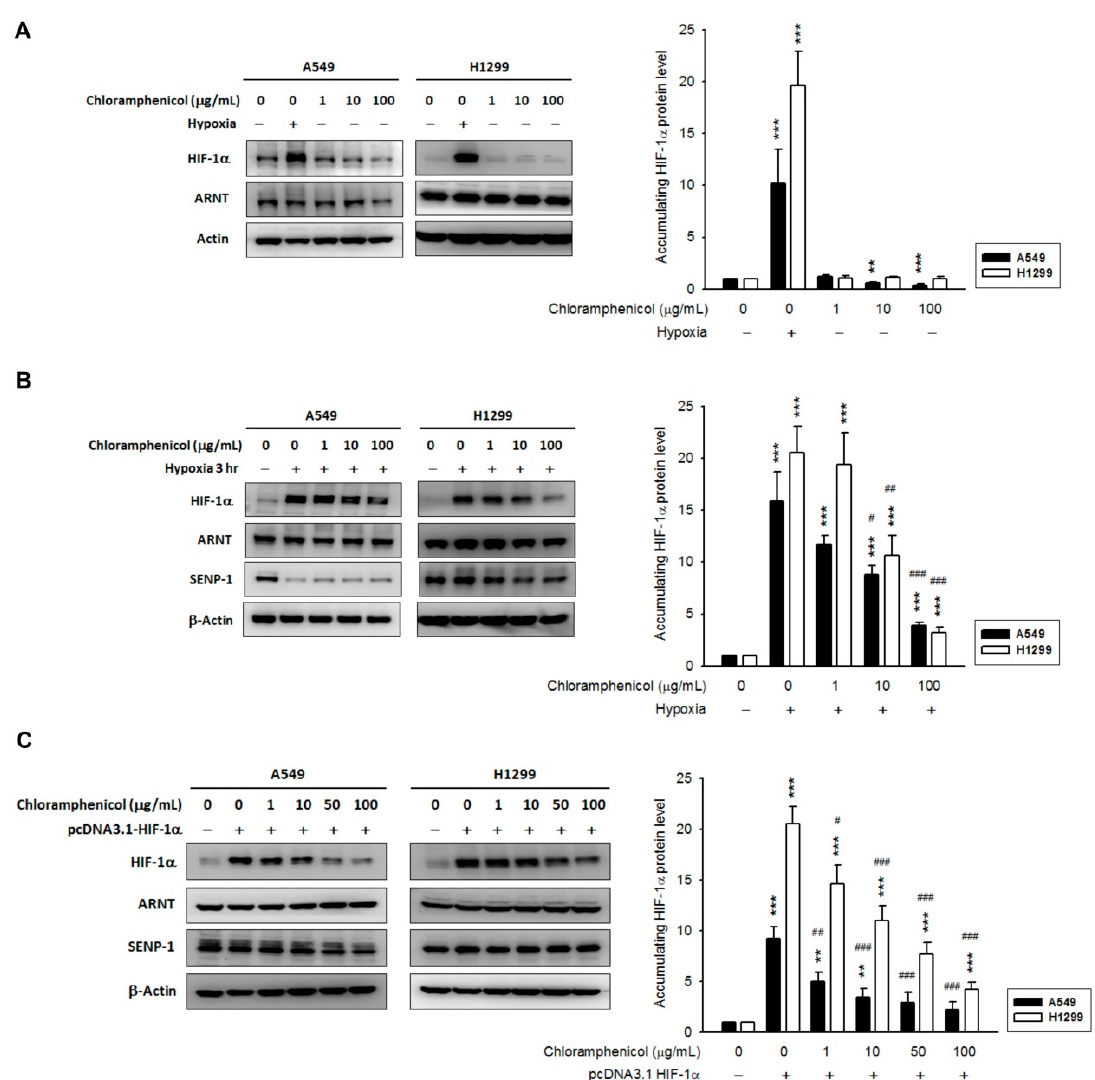
Figure 1. Chloramphenicol inhibited HIF-1 α protein accumulation in NSCLC cells in a concentration-dependent manner. ( A ) In a normoxia condition, the expression of HIF-1 α protein in H1299 cells was not unaffected by chloramphenicol (1–100 μ g/mL) treatment, whereas in A549, the basal HIF-1 α protein level was reduced. A 3 h hypoxic treatment was used as positive control. N = 3. ( B ) In both cell lines, the hypoxia-induced HIF-1 α protein accumulation was significantly inhibited by chloramphenicol (a 3-h pretreatment, followed by incubation under hypoxic conditions for another 3-h). A repression of SENP-1 levels was observed in hypoxia-treated cells. N = 3 (A549) and 5 (H1299). ( C ) In A549 and H1299 cells, with an overexpression of HIF-1 α (by transient transfection of pcDNA3.1 HIF-1 α ), exposed to chloramphenicol for 18-24 h, the level of HIF-1 α protein was significantly reduced compared to vehicle control. ARNT and SENP-1 levels remained unaltered. N = 3 (A549) and 5 (H1299). Quantification data was generated via densitometric analysis from at least three independent experiments and presented as mean ± S.E. (* p < 0.05, ** p < 0.01, and *** p < 0.001 indicates statistically significant difference from the control group; # p < 0.05, ## p < 0.01 and ### p < 0.001 indicates statistically significant difference from the hypoxia-treated control).